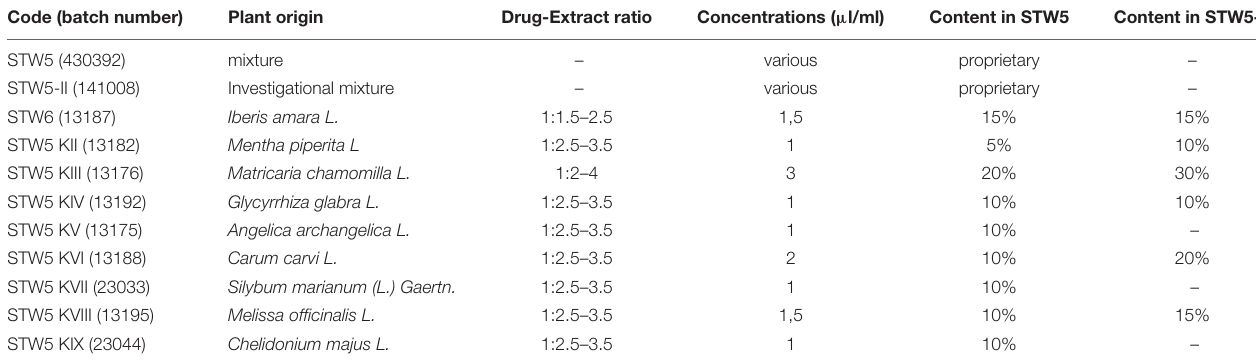
TABLE 1 | Overview of used plant extracts: Composition of STW5 and STW5-II.